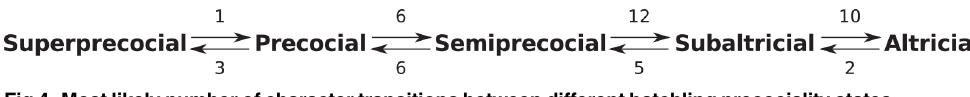
Fig 4. Most likely number of character transitions between different hatchling precociality